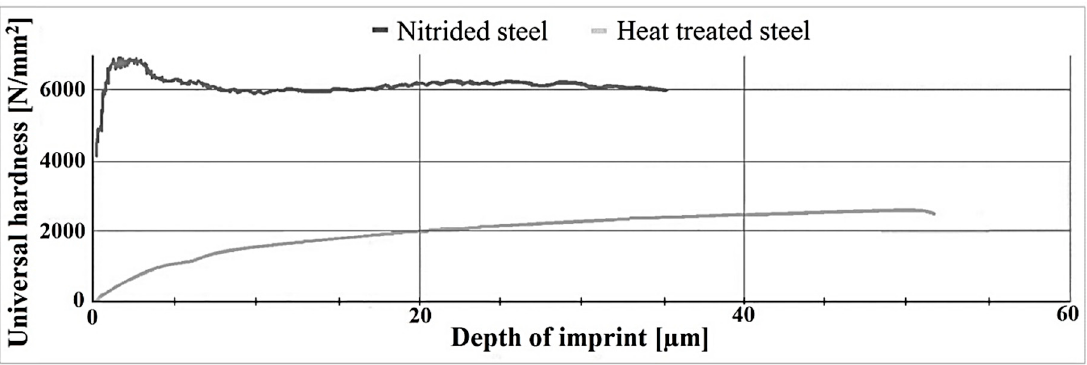
Figure 4. Values of universal hardness depending on the depth of indent; instrumented hardness tester ZWICK ZHU 2.5; load: 196 N; time of measurement: 12 s; steel equivalent 42CrMo4 (i.e., CSN 41 5142).